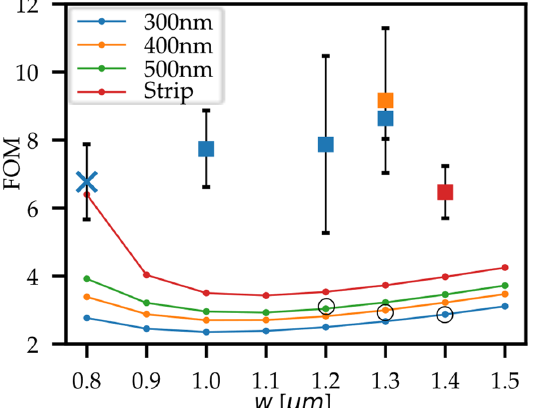
Figure 6. Comparison between the simulated 𝐹𝑂𝑀 (circular points connected by continuous lines) and the experimentally retrieved 𝐹𝑂𝑀 for the investigated structures (squares). The 𝐹𝑂𝑀𝑠 are obtained from the simulated and measured 𝐷 and 𝛤 presented in Figure 4. Error bars are ± σ . The colors of the simulation and experimental points are consistent: blue ( g = 300 nm), orange ( g = 400 nm), and red (strip waveguide). The experimental values of the strip waveguide are taken from Reference [14]. The point at w = 0.8 μ m, marked as a cross, is taken from Reference [24] and describes a structure produced with identical fabrication processes but on a different wafer lot. The three black circles mark three exemplary geometries with the same pitch.